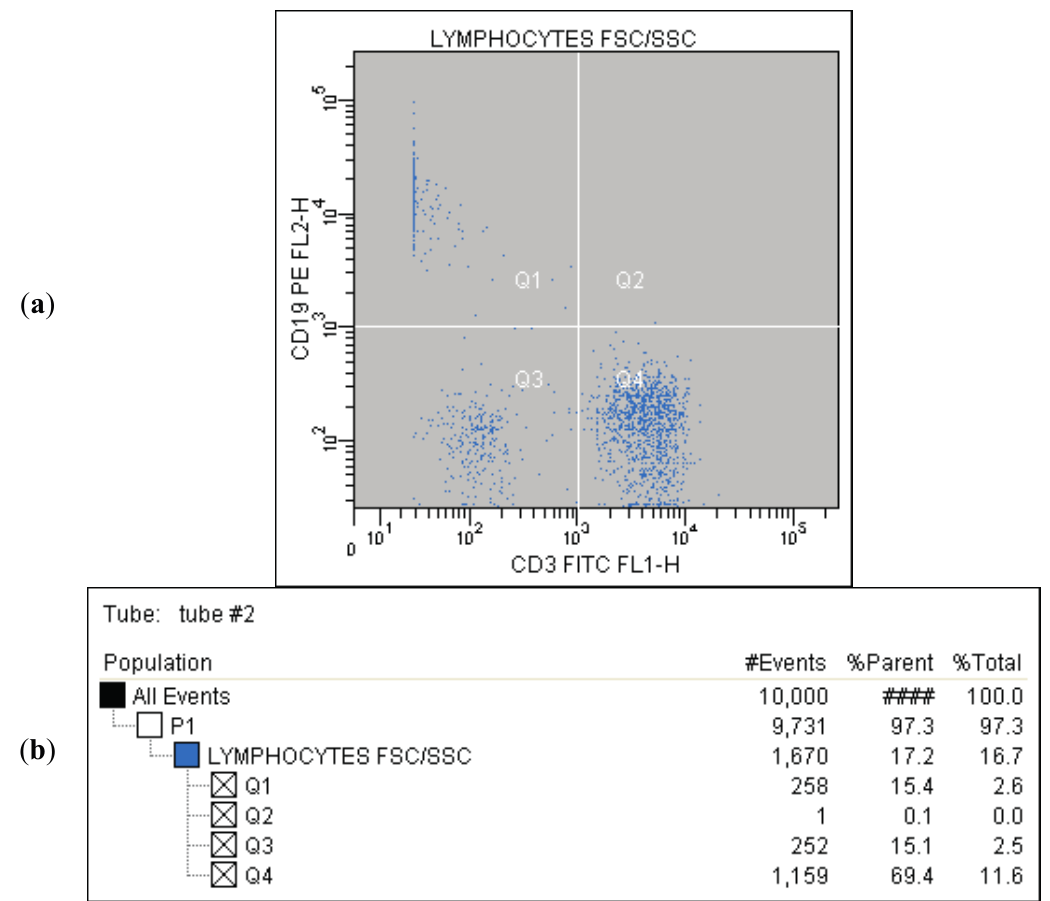
Figure 3. ( a ) Tube No. 2; Dot plot of CD3 FITC/CD19 PE with quadrant markers, differentiating lymphocytes B (CD19 + ) from lymphocytes T (CD3 + ); ( b ) Tube No. 2; Gating tree showing gating strategy for FACS analysis as well as parent and total cell percentages within each of the gates for CD19 + and CD3 + .